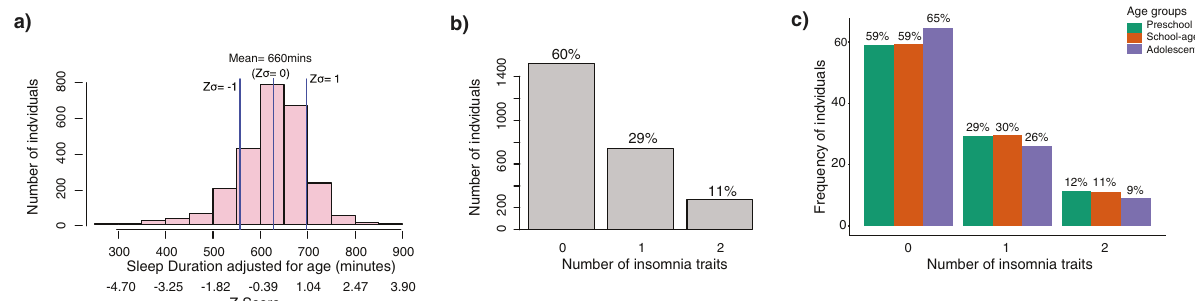
Fig. 4 Sleep trait descriptions in the SSC ASD cohort. a Sleep duration distribution adjusted for age. b Frequency of insomnia traits. c Frequency of insomnia traits in each developmental age group.